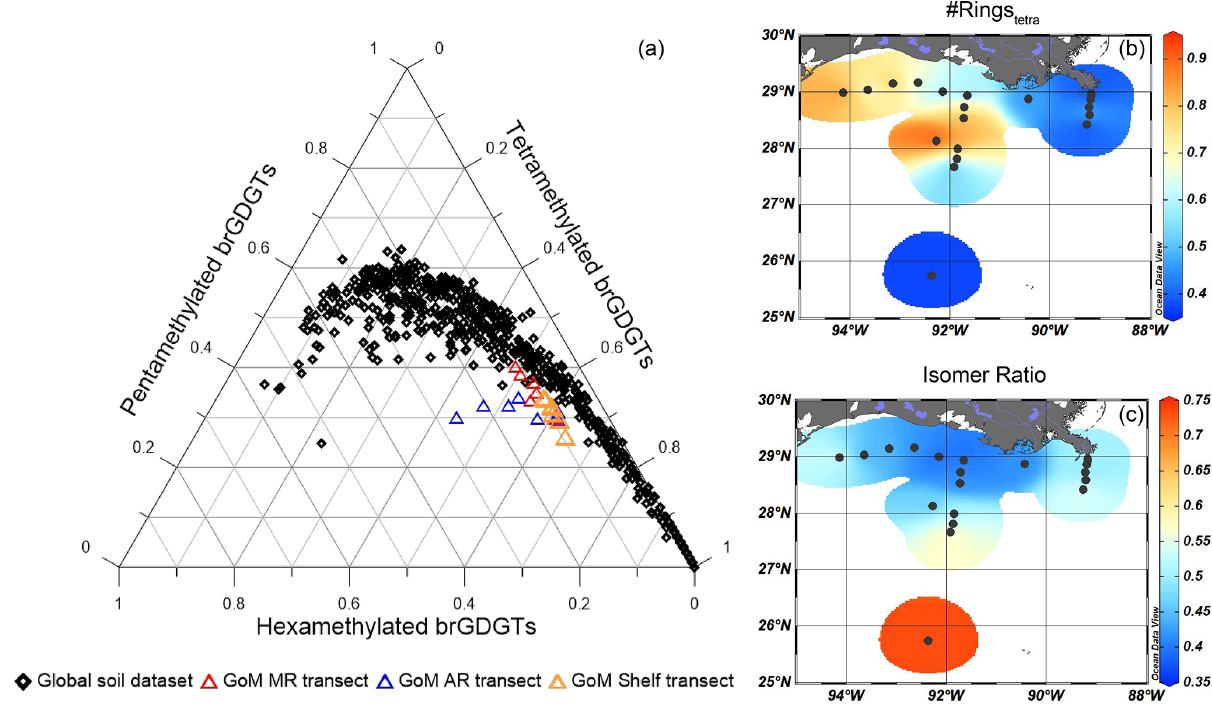
Figure 10. Assessment of the sources of brGDGTs in the GoM surface sediments. (a) Ternary diagram showing the tetra-, penta-, and hexamethylated brGDGTs in GoM surface sediments plotted together with the global soil and peat dataset (Dearing Crampton-Flood et al., 2019), (b) the #rings tetra – an indicator for marine-produced brGDGTs, and (c) the isomer ratio (IR) indicative of fluvially produced